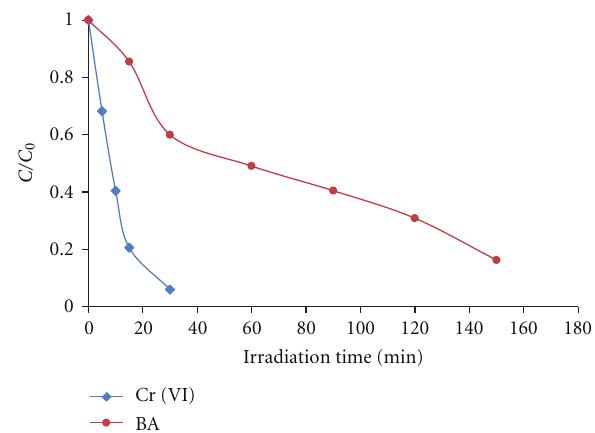
Figure 9: Kinetics of reduction of Cr(VI) and degradation of BA versus irradiation time under optimized conditions ([N-F TiO 2 ] 0 = 600mg L − 1 , Cr(VI)/BA ratio = 5, pH = 4). Table 4: Photocatalytic kinetic parameters (rate constants, half- lives, correlation coe ffi cients) of Cr(VI) and BA under